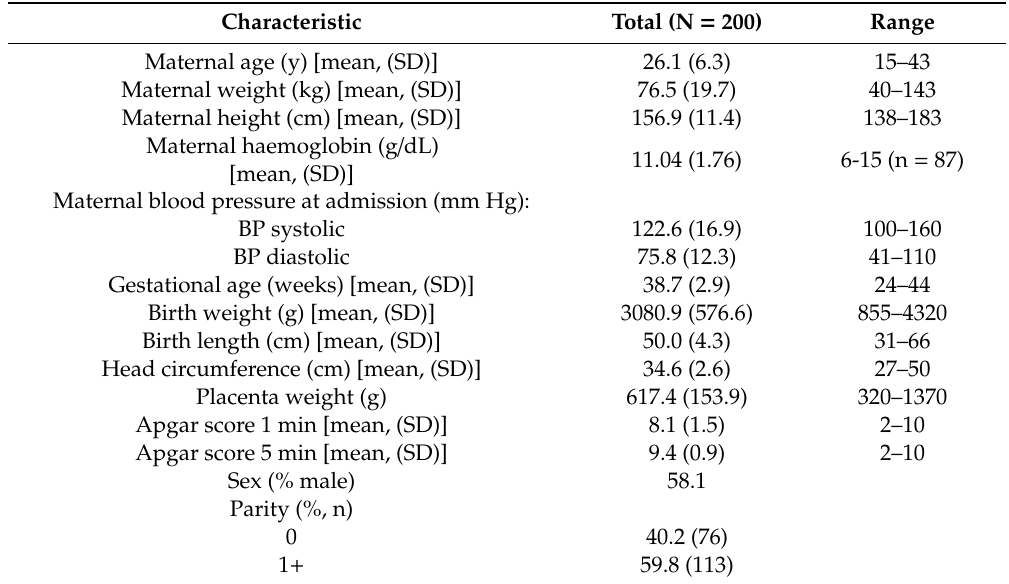
Table 2. Obstetric and birth outcomes.